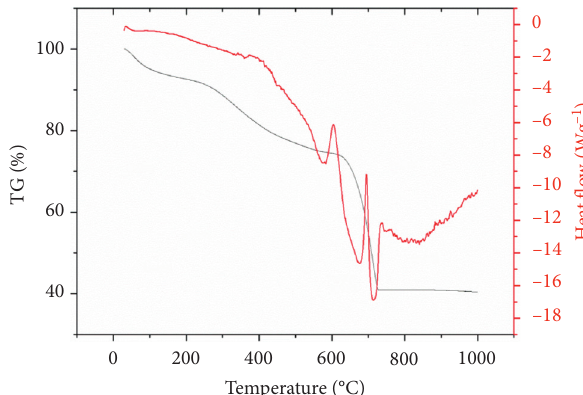
Figure 10: TG-DSC spectra of sample 1.